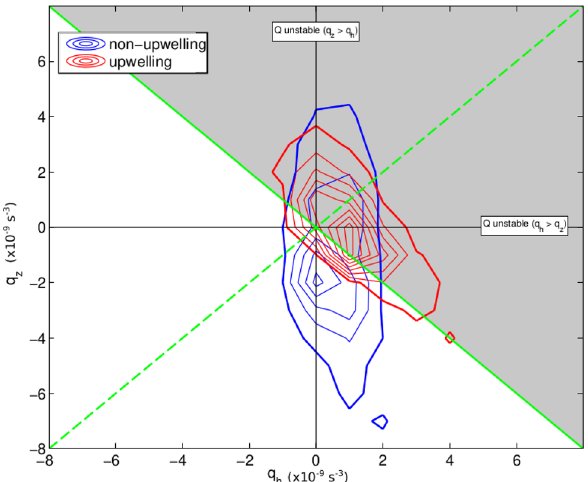
Figure 5. Comparison of horizontal and vertical potential vorticity during upwelling and non-upwelling periods. A 2d-histogram of q h and q z (s −3 ) for upwelling (red) and non-upwelling (blue) periods for the area between 0–1°S, 93–91°W. 1% of values contour is indicated using a thicker line. Q = 0 (i.e. q h + q z = 0) is marked as a thick green line, and q h = q z is indicated as a dashed green line. The area of parameter space favourable to the development of submesoscale instabilities is shaded grey.